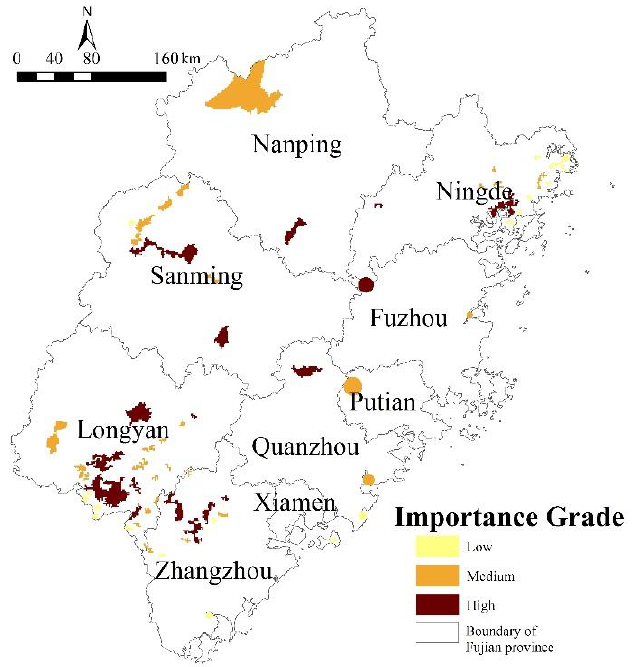
Figure 4. CFC value distribution of ecological sources in Fujian. Note: CFC value is the current flow centrality.